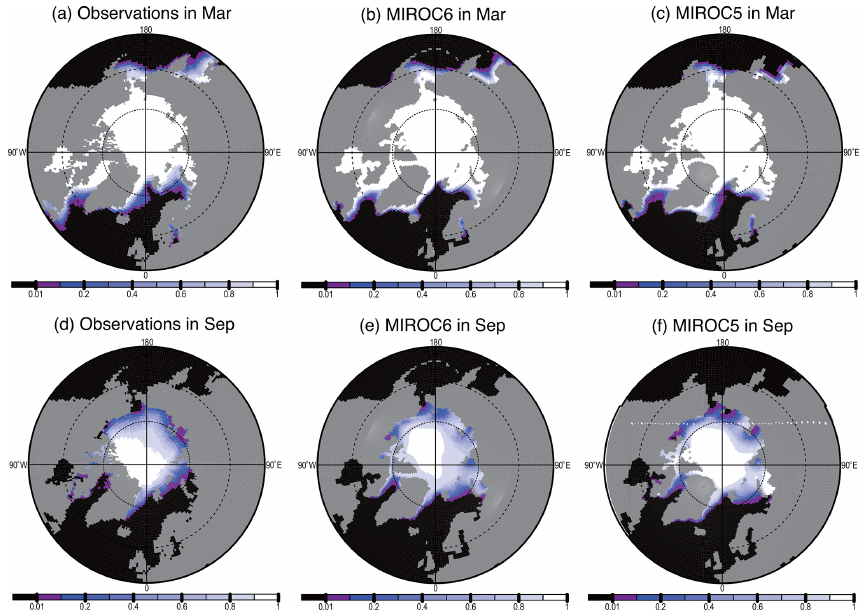
Figure 17. Northern Hemisphere sea ice concentrations in March (a, b, c) and September (d, e, f) for observations (a, d) , MIROC6 b, e) , and MIROC5 (c, f) . The unit is nondimensional. Satellite-based sea ice concentration data of the SSM/I are used as